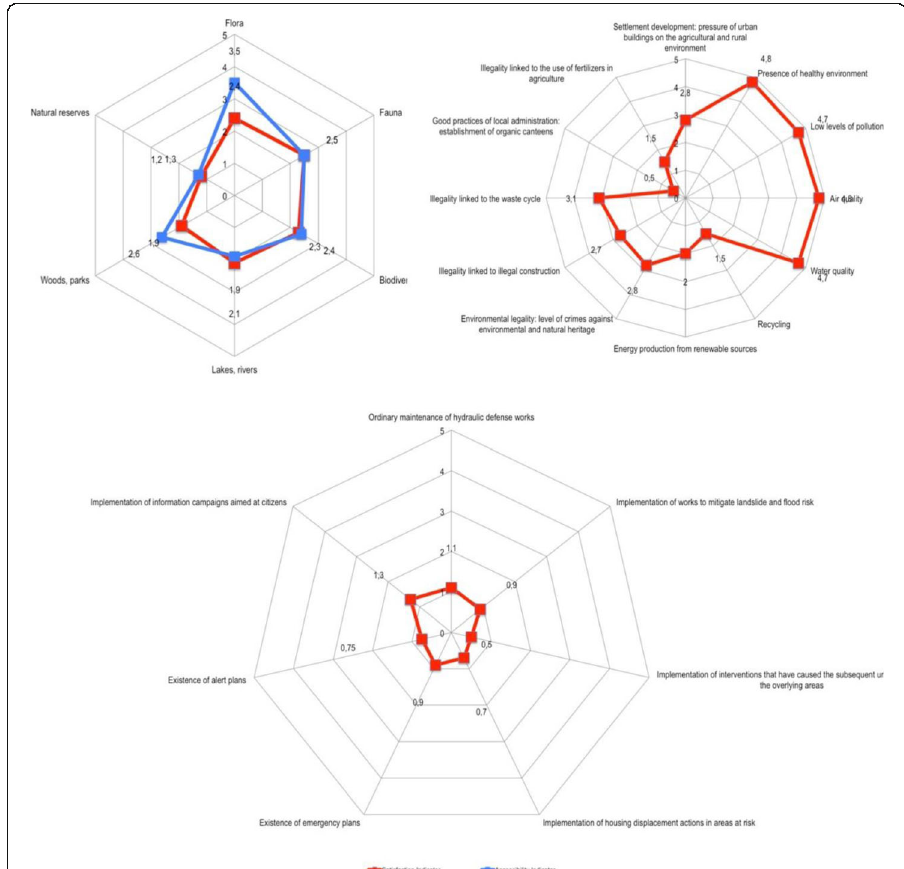
Fig. 5 Profile of the local environmental landscape heritage according to the rural residents in the territory under investigation (average scores, assessments on a scale from 1 to 5). Source: our processing on data collected through quantitative